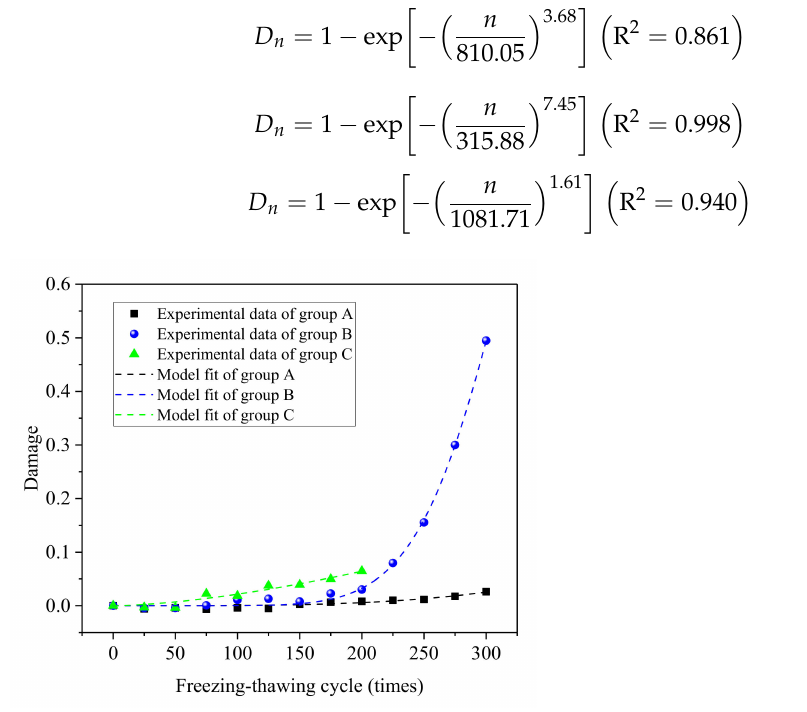
Figure 16. Comparison between damage model and test